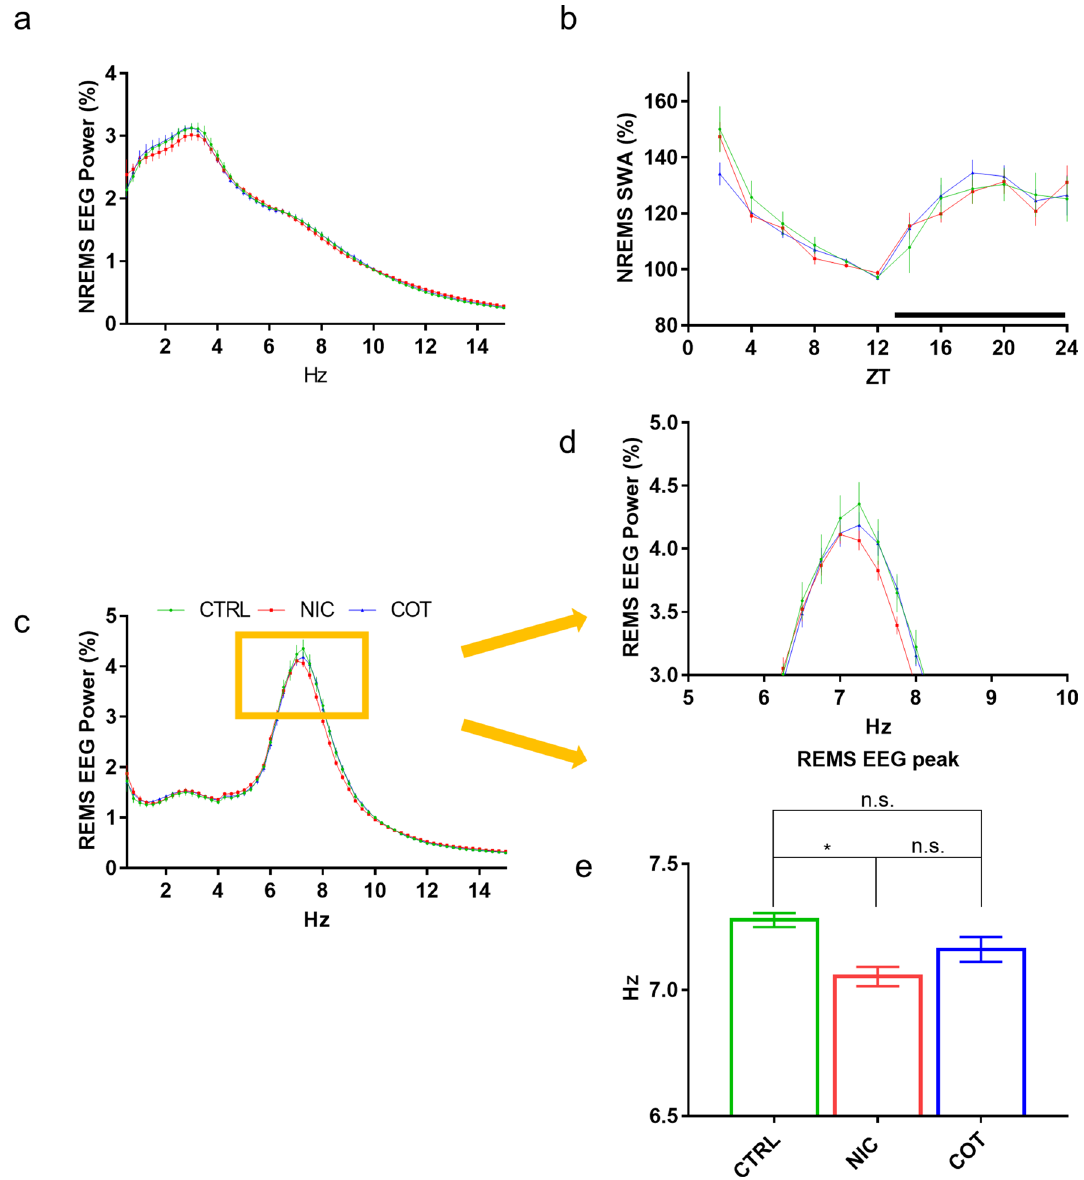
Figure 4. Electroencephalogram analysis in sleep during baseline recordings. Panel ( a ) shows electroencephalographic (EEG) power spectral density in baseline recordings during non-rapid-eye-movement sleep (NREMS) expressed as a percentage of total EEG spectral power. Panel ( b ) shows power in the delta frequency range (1–4 Hz, EEG slow-wave activity, SWA) during NREMS in baseline conditions. EEG SWA was normalized to values in the last 4 h of the light period. Panel ( c ) shows EEG power spectral density in baseline recordings during rapid-eye-movement sleep (REMS) expressed as a percentage of total EEG spectral power. Panel ( d ) shows a magnification of the orange square in panel ( c ). Panel ( e ) shows the values of the EEG peak during REMS. All data refer to adult male mice perinatally exposed to nicotine (NIC, n = 14), cotinine (COT, n = 14) or just the vehicle (CTRL, n = 11). * p (adjusted for multiple comparisons) < 0.05; n.s., not